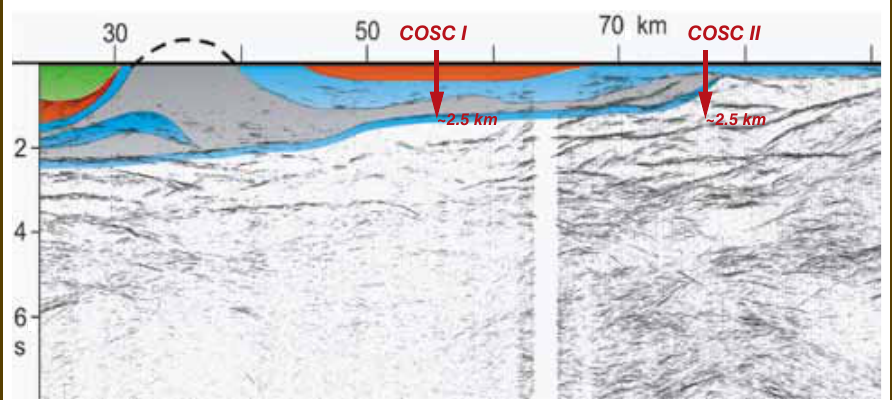
Figure 4. Detailed view from the regional seismic profile (from the early 1990s) with approximate drillhole locations. Note that the vertical scale is time, and that borehole locations are only approximate. Actual locations will be based on new seismic reflection data that is currently being processed (from Gee et al.